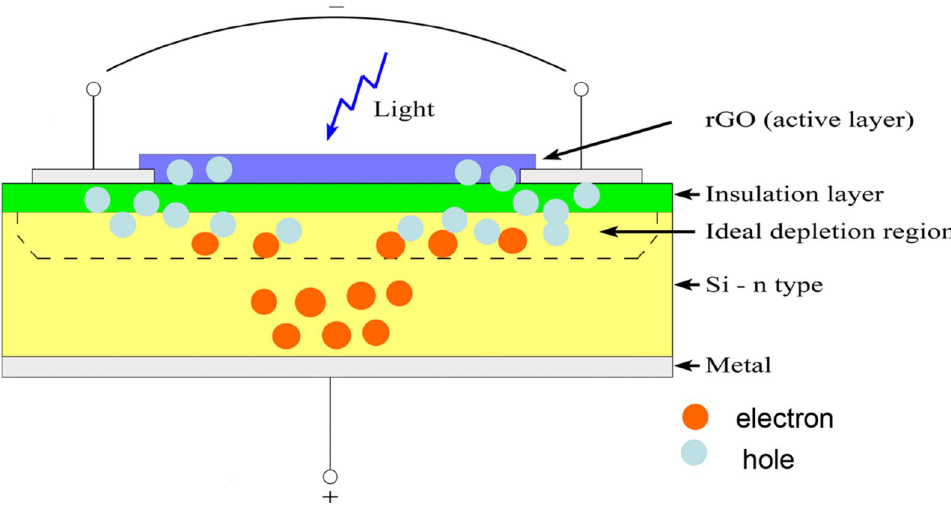
Figure 5. Schematic representation of the rGO/n-Si photodetector at reverse